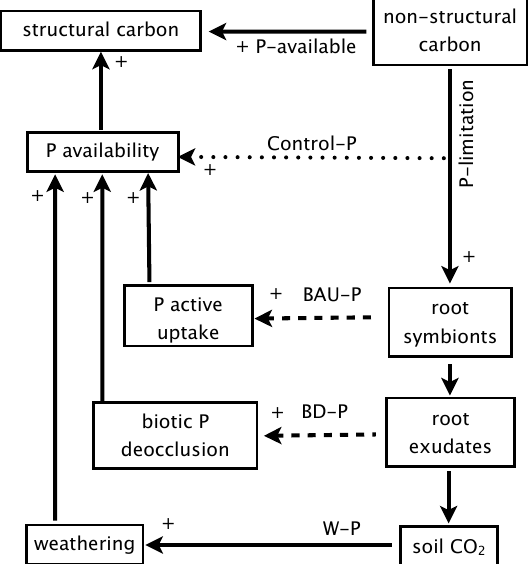
Figure 6. Diagram showing the modelled carbon feedbacks on the P availability. Simulation scenarios are defined with respect to these feedbacks. Dashed line represents the effects that can be turned off and dotted line represents the unrealistic